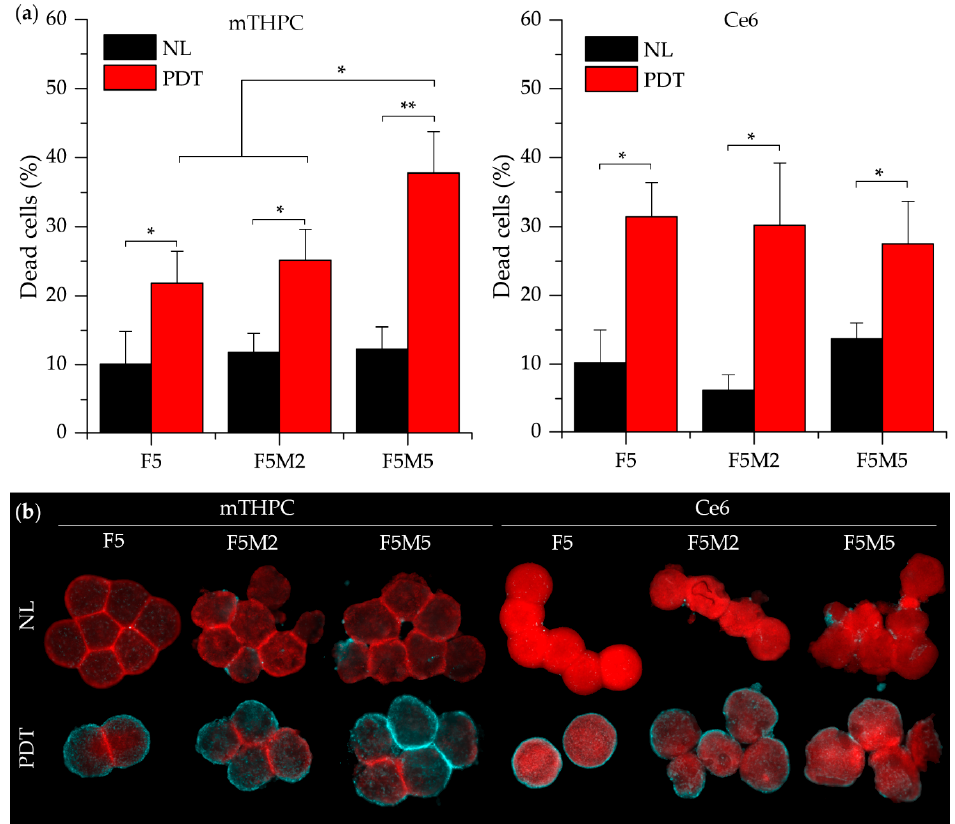
( b ) Typical fluorescence images of spheroids stained with PS (red) and annexin-V-FITC dye (cyan) as apoptotic marker without irradiation and 6 h after PDT (20 J / cm 2 ). *: statistically significant, p < 0.05. Scale bar—500 µ